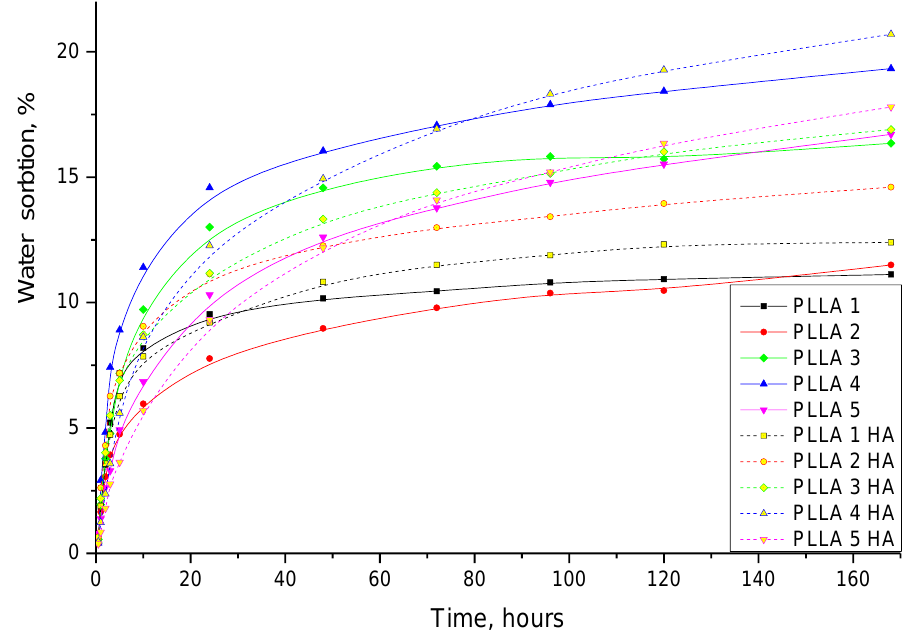
Figure 7. Kinetic curves for water absorption by different PLLA film samples.